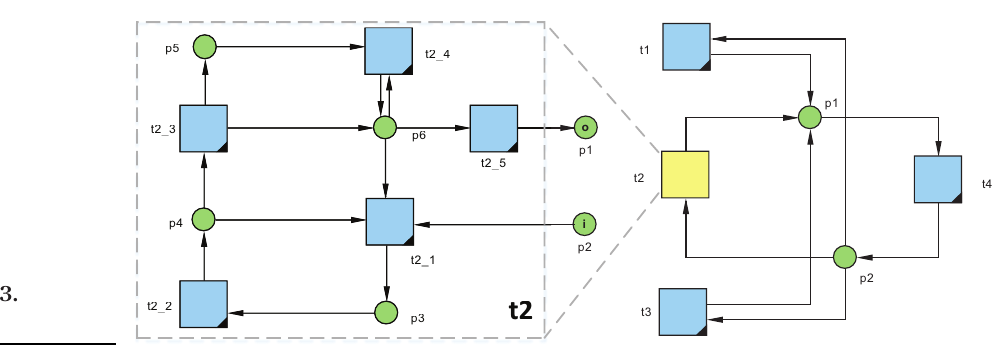
Figure 2. Different kinds of system activities of the Petri